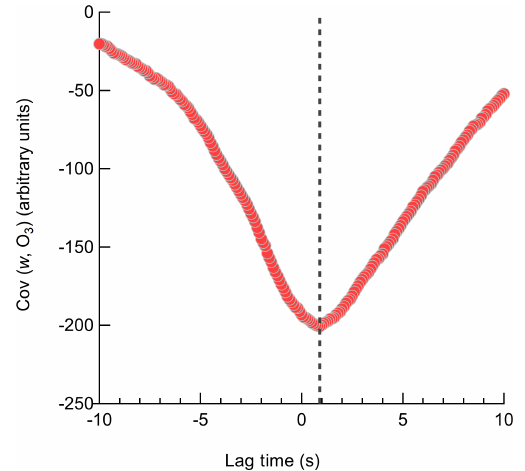
Figure 10. Lag time determination for an individual 27min O 3 flux averaging period. The lag time for this flux period is determined from the maximum of the covariance to be 0.9s which compares reasonably with the volumetric evacuation time of the inlet of 1.7 to